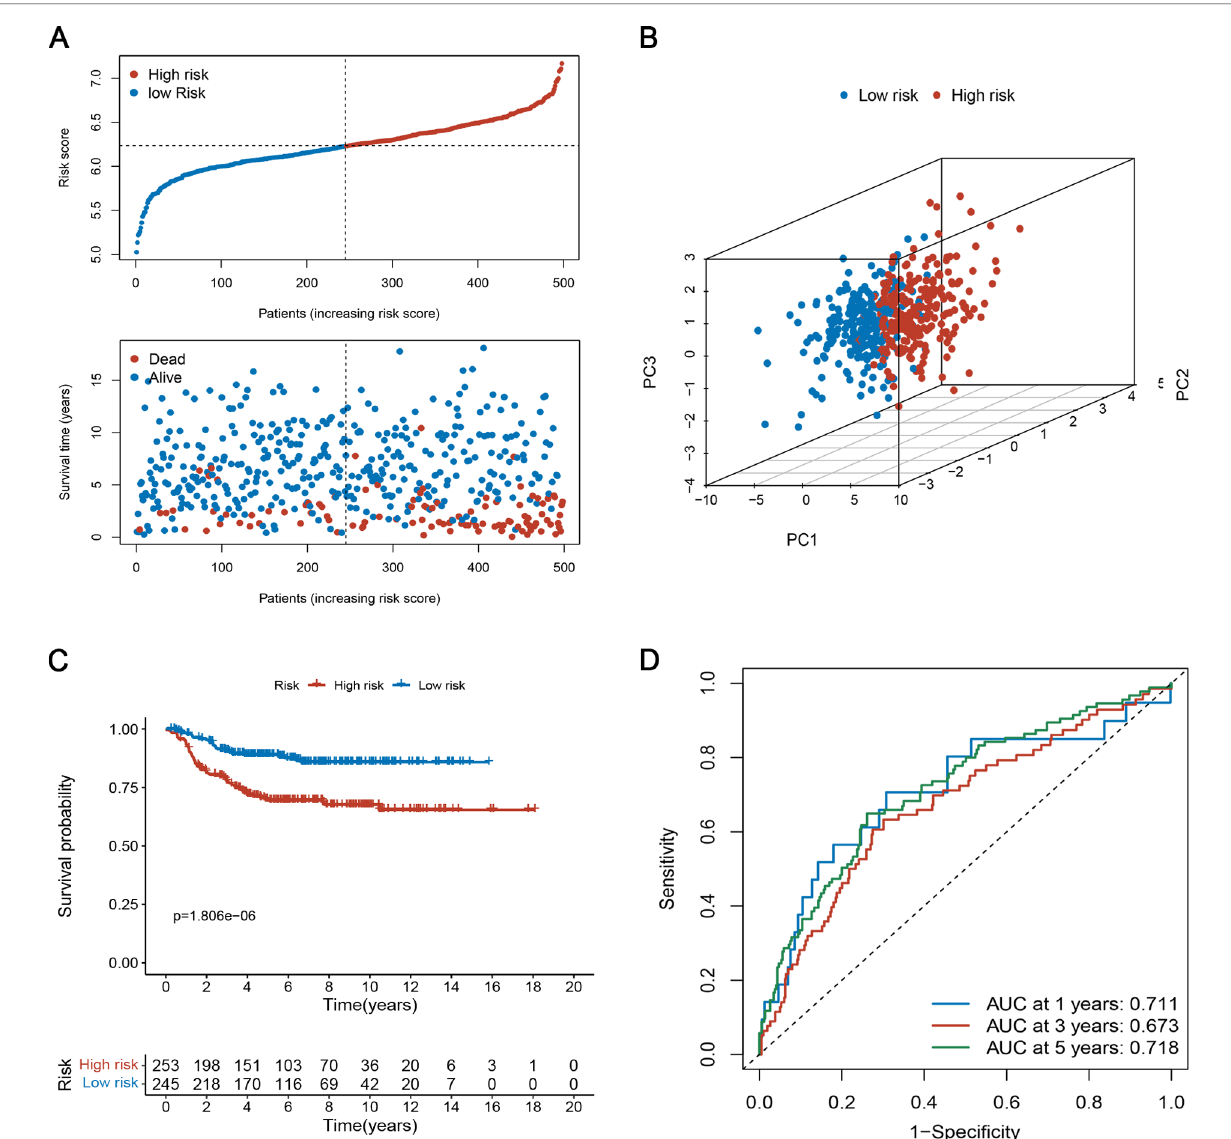
FIGURE 5 Evaluation of the prognostic risk model in the testing set. ( A ) The survival distribution of patients in the training focus increased patient mortality with the increase in risk score. ( B ) PCA showed remarkable differences between the two risk groups. ( C ) Kaplan-Meier survival curve between the high- and low- risk groups. ( D ) Time-dependent ROC curve based on risk